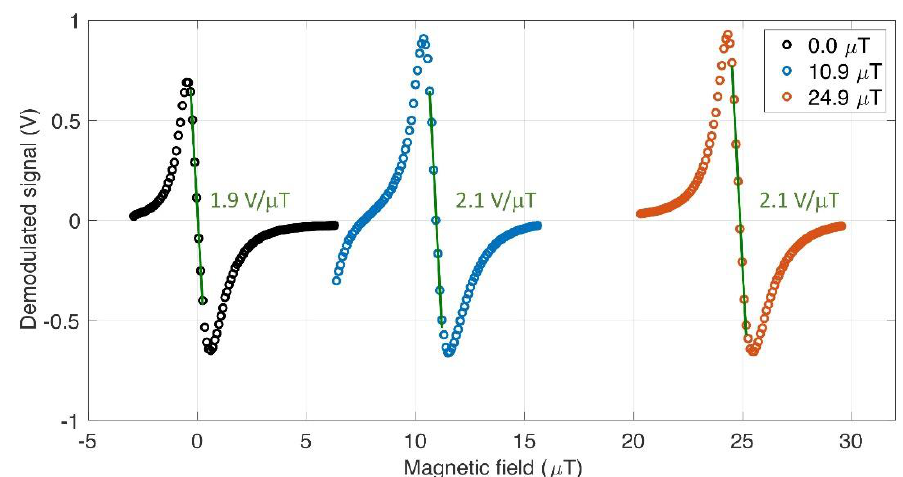
Figure 5. The lock-in amplifier (LIA) signal as a function of the axial magnetic field applied to the atom. The microwave frequency is tuned to measure each target field of 0.0 μT (black), 10.9 μT (blue), and 24.9 μT (red). Green curve: linear fitting near zero-crossing for each dispersive curve.